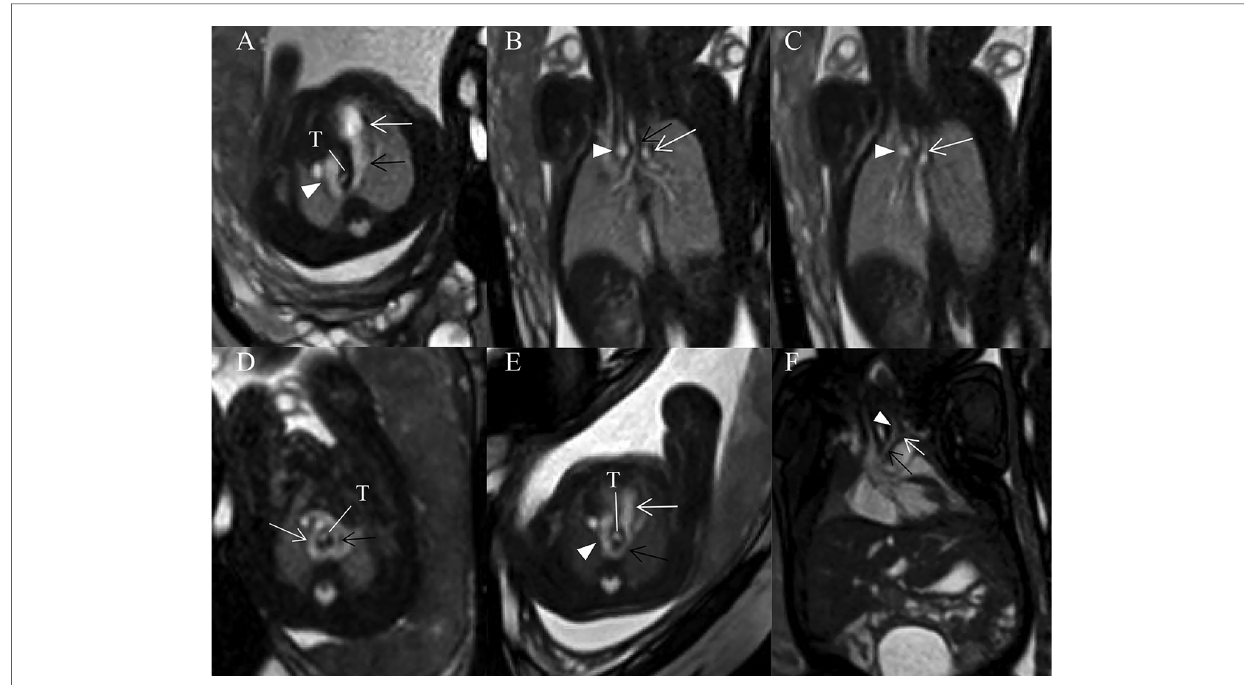
FIGURE 3 ( A – F ) Fetuses with subtype CVRs. ( A ) A 27 weeks ’ gestation fetus with RAA with ALSA and left DA. Fetal cardiovascular magnetic resonance SSFP sequence transverse view of AA image showed right aortic arch (white arrowhead), left-sided DA (black open arrow) and main pulmonary artery (white open arrow) forming a U-shaped loop around the fetal trachea (T). ( B ) Same fetus with ( A ). Fetal cardiovascular magnetic resonance SSFP sequence coronary view image showed the trachea stenosis (black open arrow), right aortic arch (white arrowhead) and aberrant left subclavian artery (white open arrow). ( C ) Same fetus as ( A ). Fetal cardiovascular magnetic resonance SSFP sequence coronary view image showed right aortic arch (white arrowhead) and aberrant left subclavian artery (white open arrow). ( D ) A 28 weeks ’ gestation fetus with DAA. Fetal cardiovascular magnetic resonance SSFP sequence transverse view of AA image showed right (white open arrow, larger) and left aortic arches (black open arrow, smaller) forming an O-shaped loop around the trachea (T). ( E ) A 25 weeks ’ gestation fetus with RAA with mirror-image branching and RLDA. Fetal cardiovascular magnetic resonance SSFP sequence transverse view of AA image showed retroesophageal ductus (black open arrow), right aortic arch (white arrowhead), and main pulmonary artery (white open arrow). A U-shaped loop around the fetal trachea (T). ( F ) A 37 weeks ’ gestation fetus with RAA with mirror-image branching and RLDA. Fetal cardiac magnetic resonance SSFP coronal view image showed left innominate artery (black arrow), left common carotid artery (white arrowhead), and left subclavian artery (white open